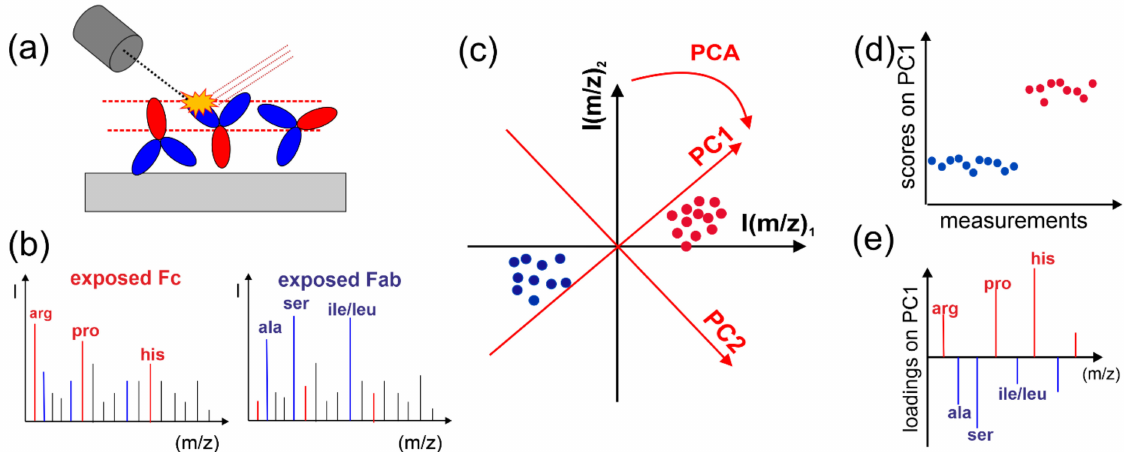
Figure 1. ( a , b ) Comparison of the antibody orientation in different samples, based on TOF-SIMS sensitivity of the outermost region of immobilized proteins (marked by red horizontal lines) ( a ) ex- amined with regard to their amino acid composition ( b ), distinct for exposed Fc and Fab domains. ( c – e ) PCA examines numerous TOF-SIMS measurements (points) in a multidimensional space with